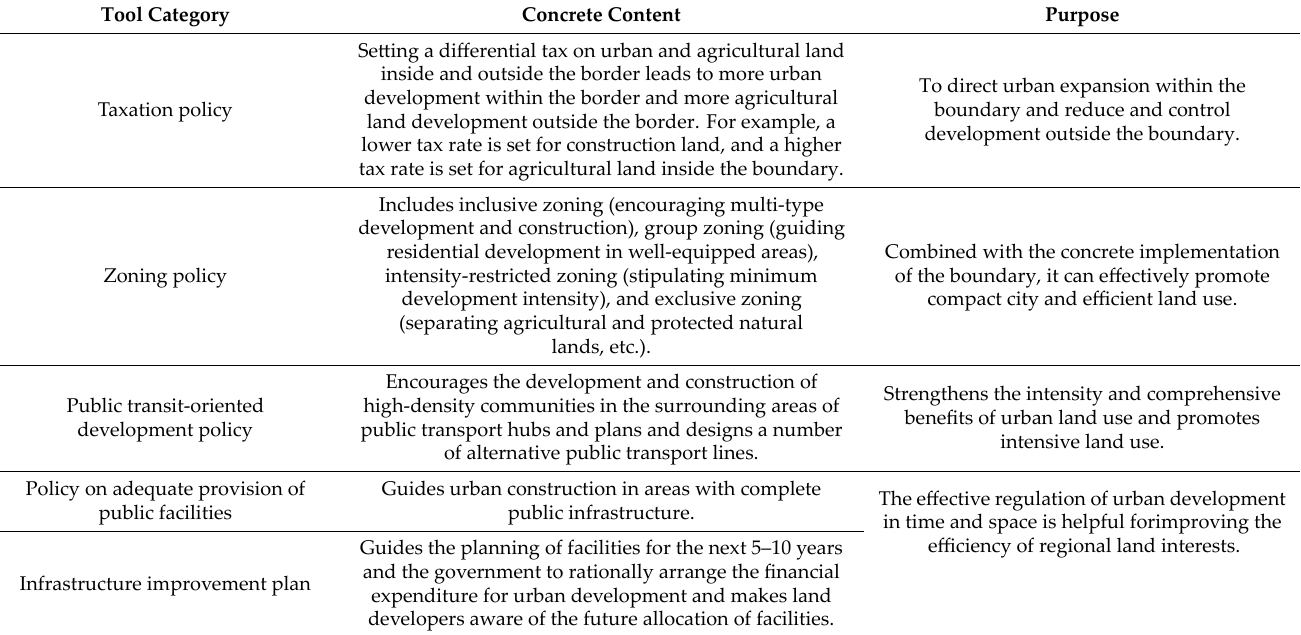
Table 1. Supporting policy tools for urban growth boundaries in the United